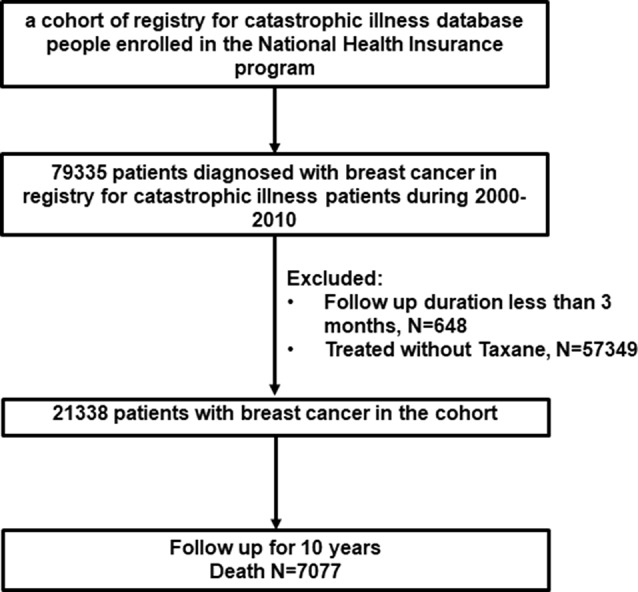
Patient of breast cancer disposition.